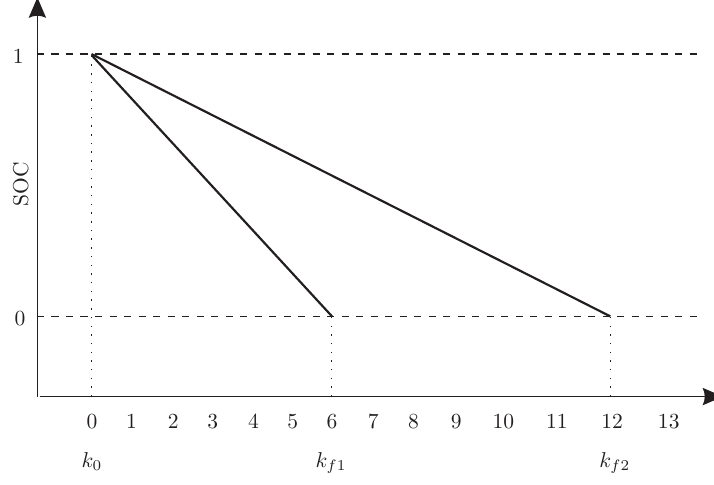
Figure 14. Illustration of the state of health of